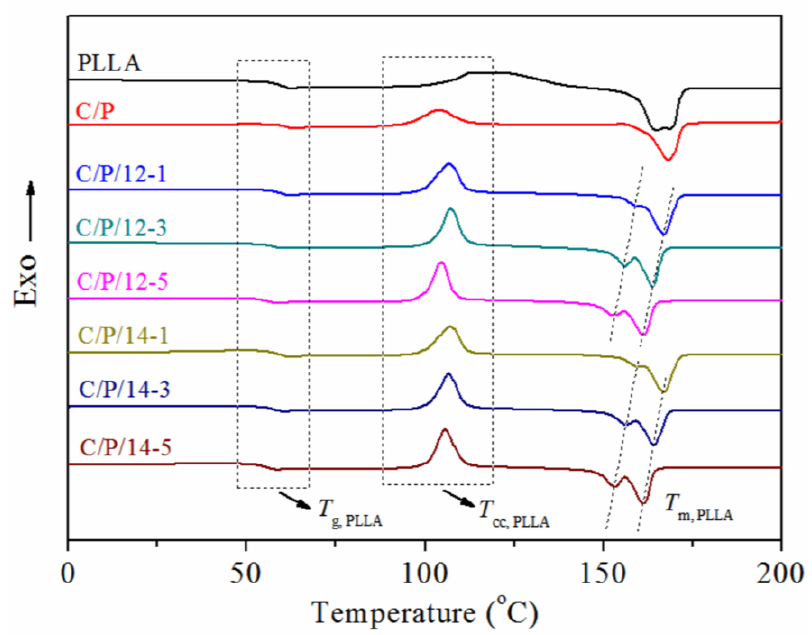
Figure 5. DSC curves for PLLA, C/P blend, and the composites obtained from the second heating scans. Table 2. Thermal properties of PLLA, C/P blend, and the composites.